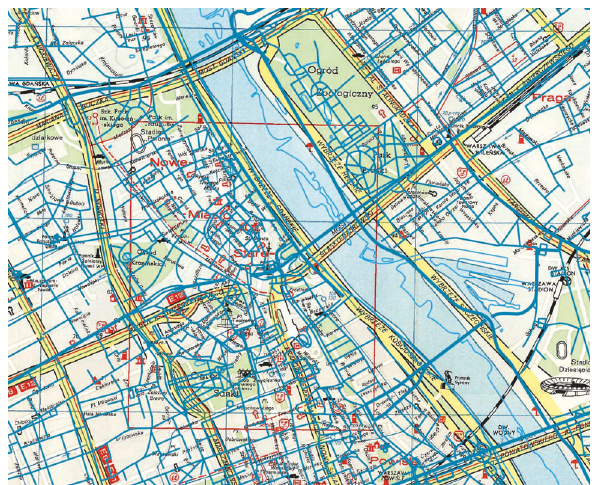
Fig. 4. Geometric deformation (a part of an original map of Warsaw from 1970 with overlay correct line